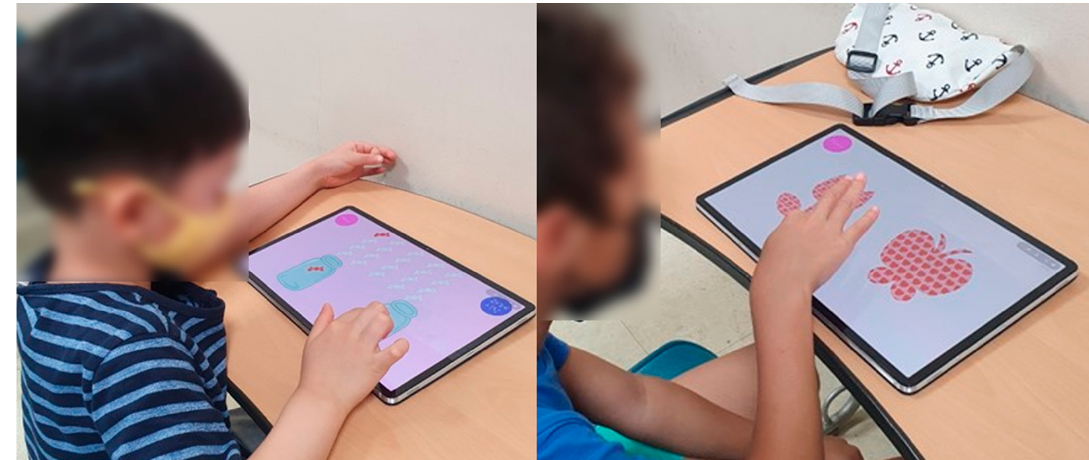
Figure 2. Digital cognitive function testing using a tablet-based app, patent application 10-2020- 0147889 (Republic of Korea, 2022).